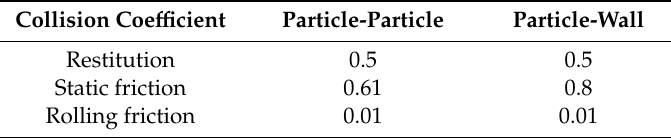
Figure 2. Particle shape models: ( a ) cylinder particle, ( b ) pie ‐ shaped particle, ( c ) spherical particle. Table 2. Collision parameters in the Hertz–Mindlin contact model .